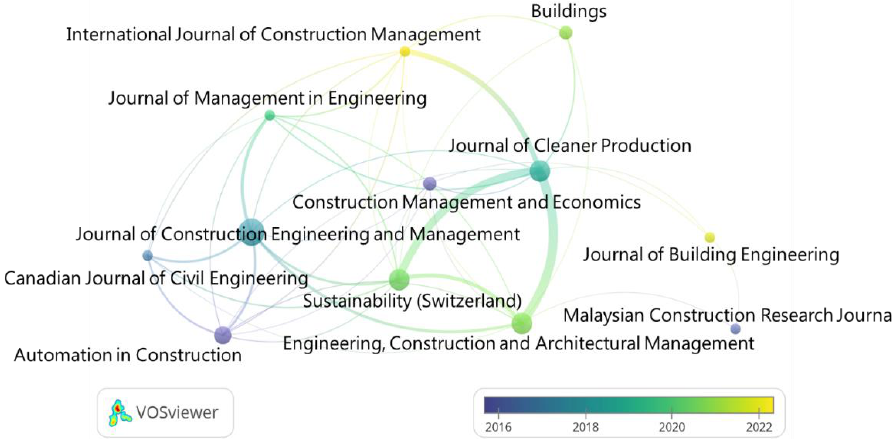
Figure 3. Journal citation network. Table 2. Journals with no fewer than 3 cited articles of RM in PC.